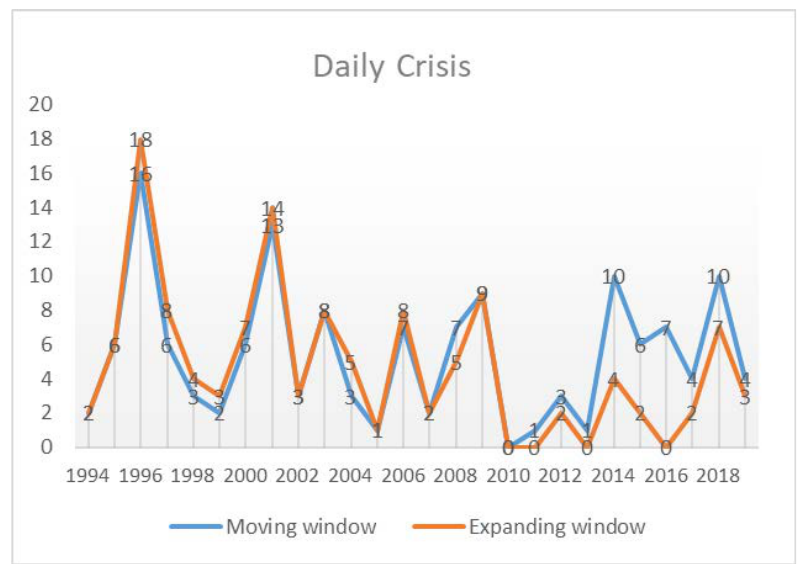
Figure 2. US natural gas crises processing.